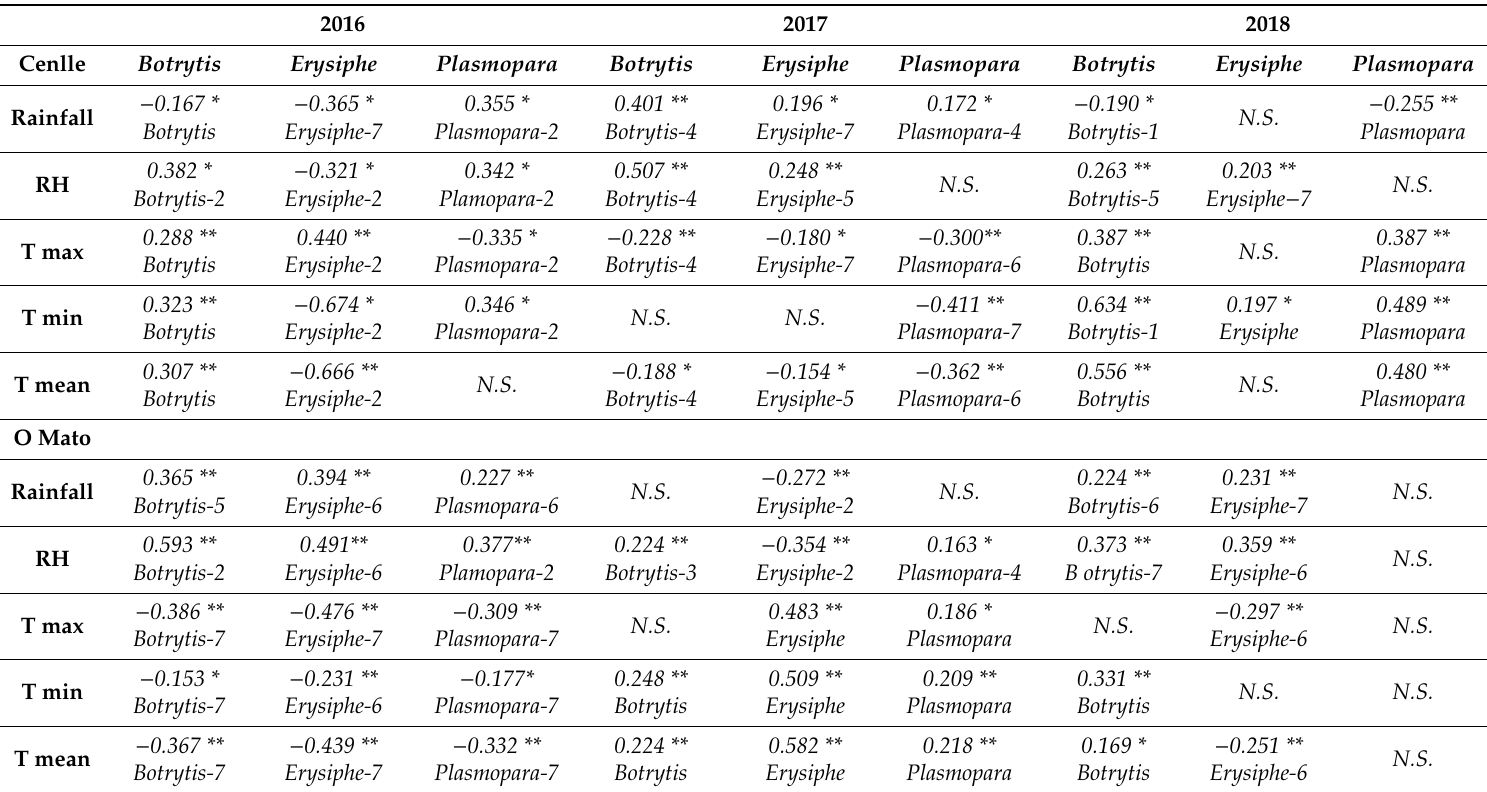
Table 4. Spearman’s rank correlation of di ff erent parameters for the studied cultivars. Spore concentrations ( Botrytis , Erysiphe and Plasmopara ) and the